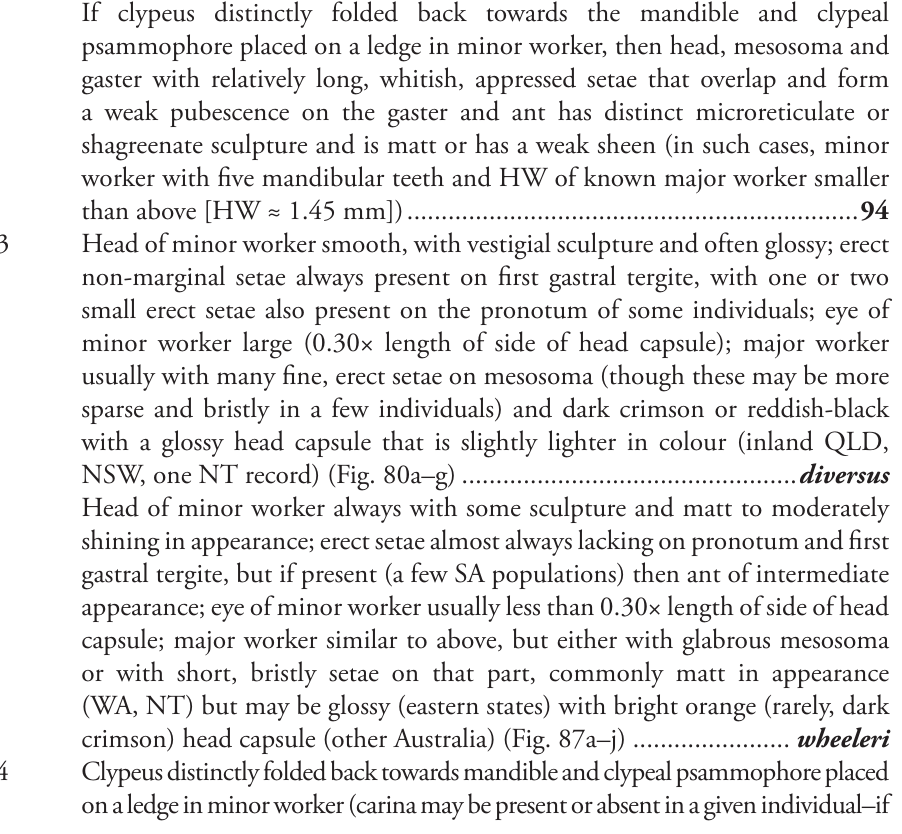
Clypeus distinctly folded back towards mandible and clypeal psammophore placed on a ledge in minor worker (carina may be present or absent in a given